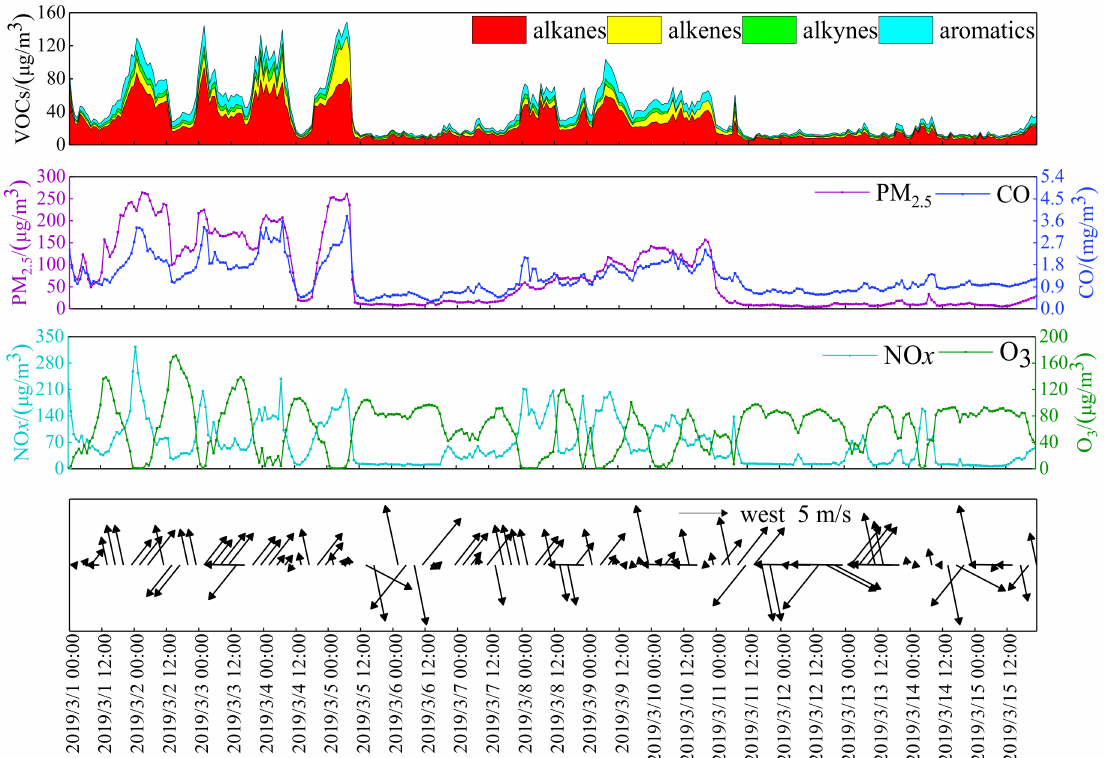
Figure 1. Time series of observed VOCs, PM 2.5 , CO, NO x , O 3 and meteorological parameters (wind speed and wind